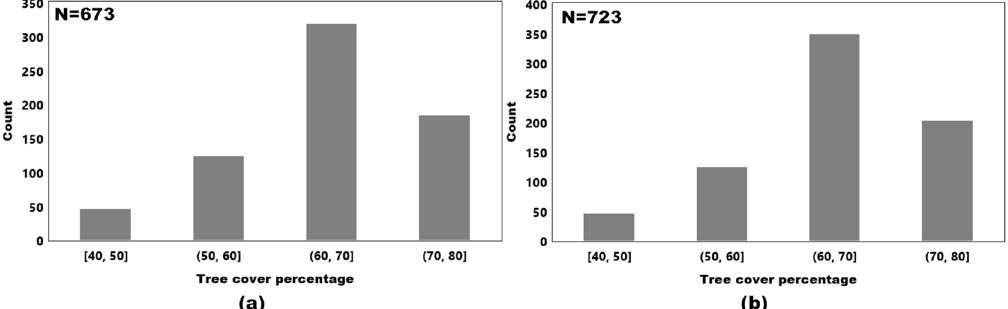
Figure 11. ( a , b ) are the distribution of tree cover percentage of MODIS pixel corresponding to the used V005-MODIS-CI and V006-MODIS-CI, respectively.